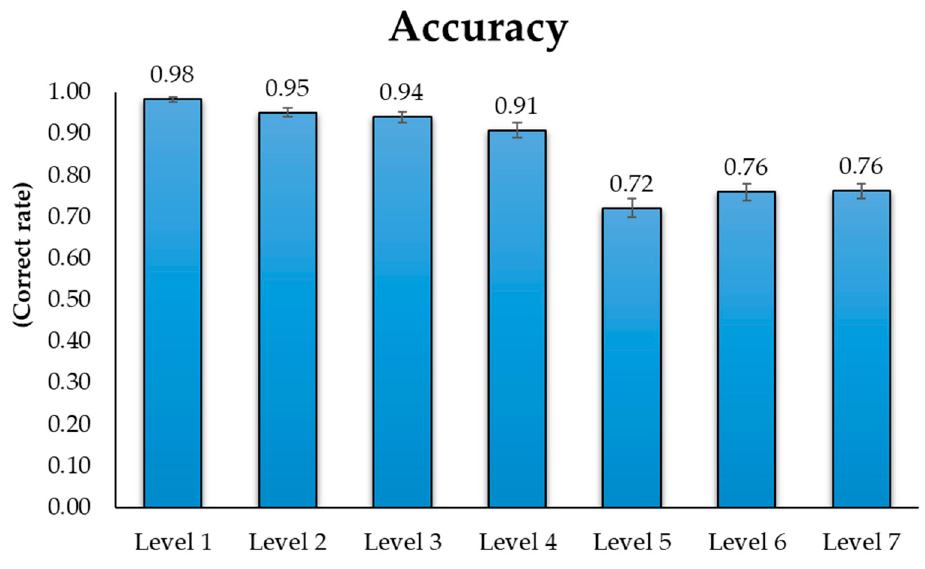
Figure A1. Accuracy of each level in this study.